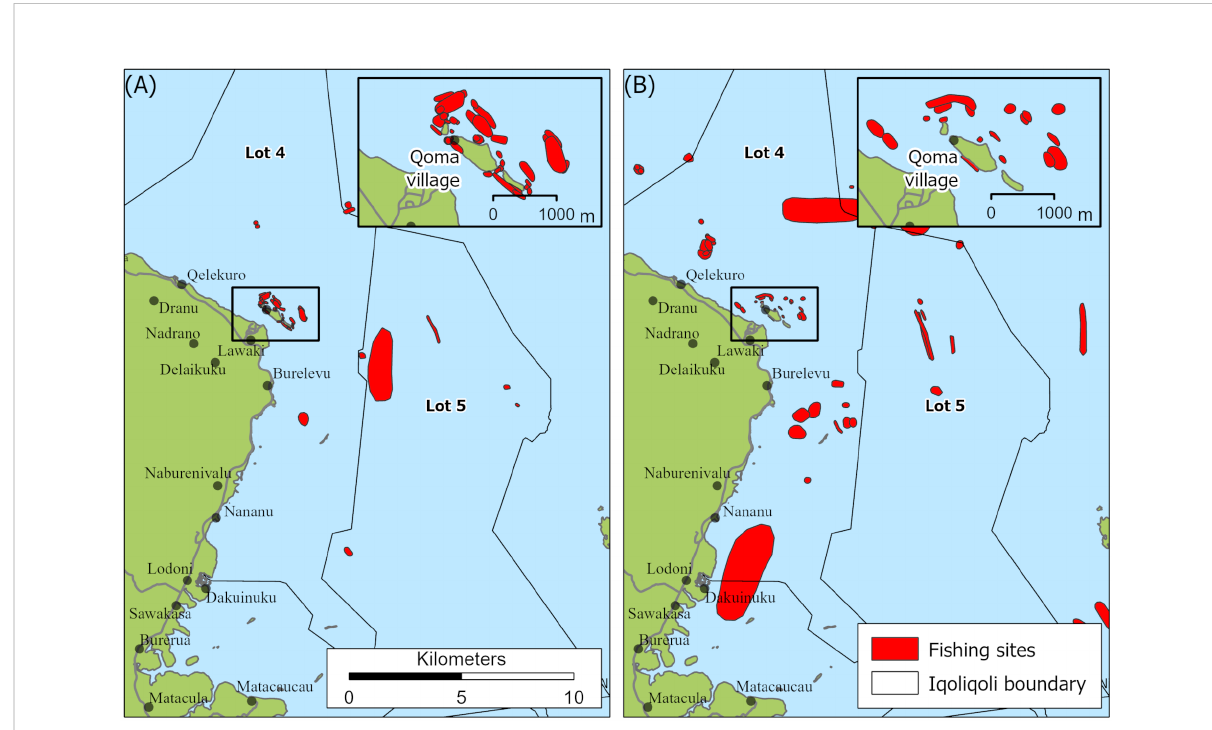
FIGURE 3 Fishing sites identi fi ed by female participants (A) and male participants (B) through PGIS mapping interviews. The Lots labelled in these maps are the traditional fi shing boundaries allotted and marked out by the Native Lands and Fisheries Commission between 1958 – 1967 and the records are kept with the Ministry of iTaukei Affairs of fi